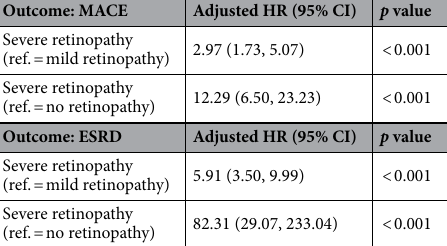
Table 2. Hazard ratios of end-stage renal disease (ESRD) and major adverse cardiac events (MACE) through severe and mild retinopathy from multi-state model. Adjusted hazard ratios were estimated from multi-state models adjusted for age at type 1 diabetes diagnosis and